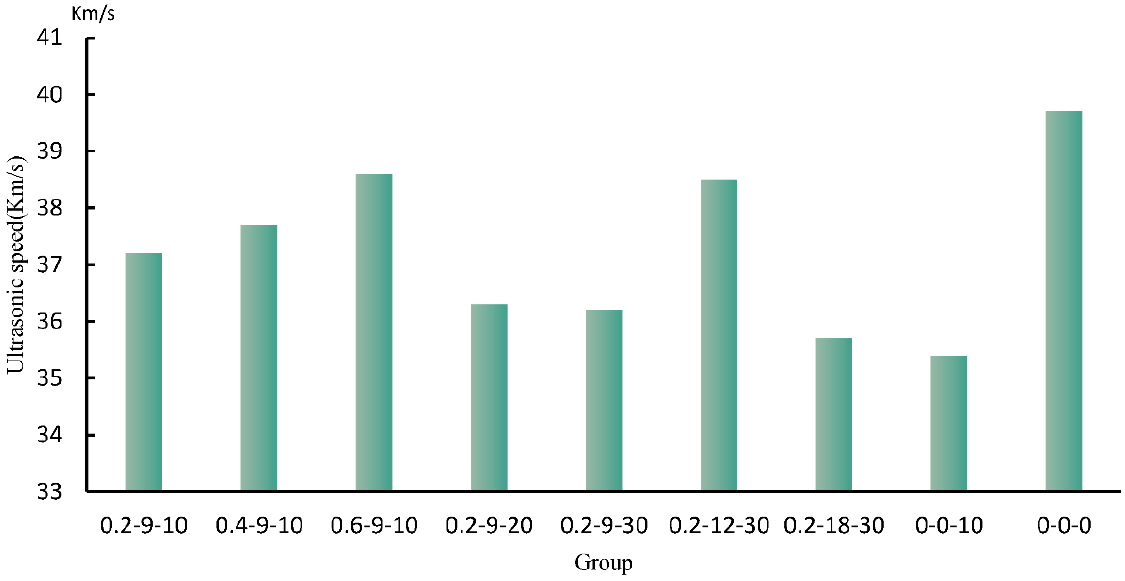
Figure 12. The diagram of the ultrasonic wave Figure 12. Contrast diagram of the ultrasonic wave velocity and water absorption.